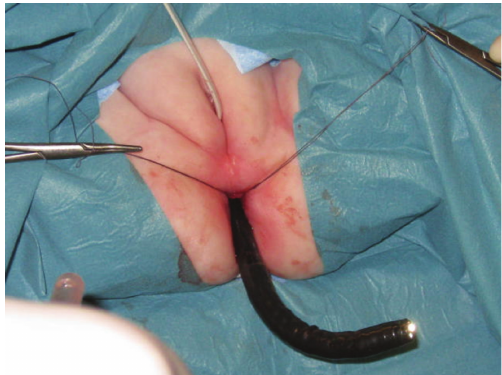
Figure 7: Holding stitches were set through the compressed 2cm distance, and the blind ending was opened under excellent view. Then the endoscope could pass.